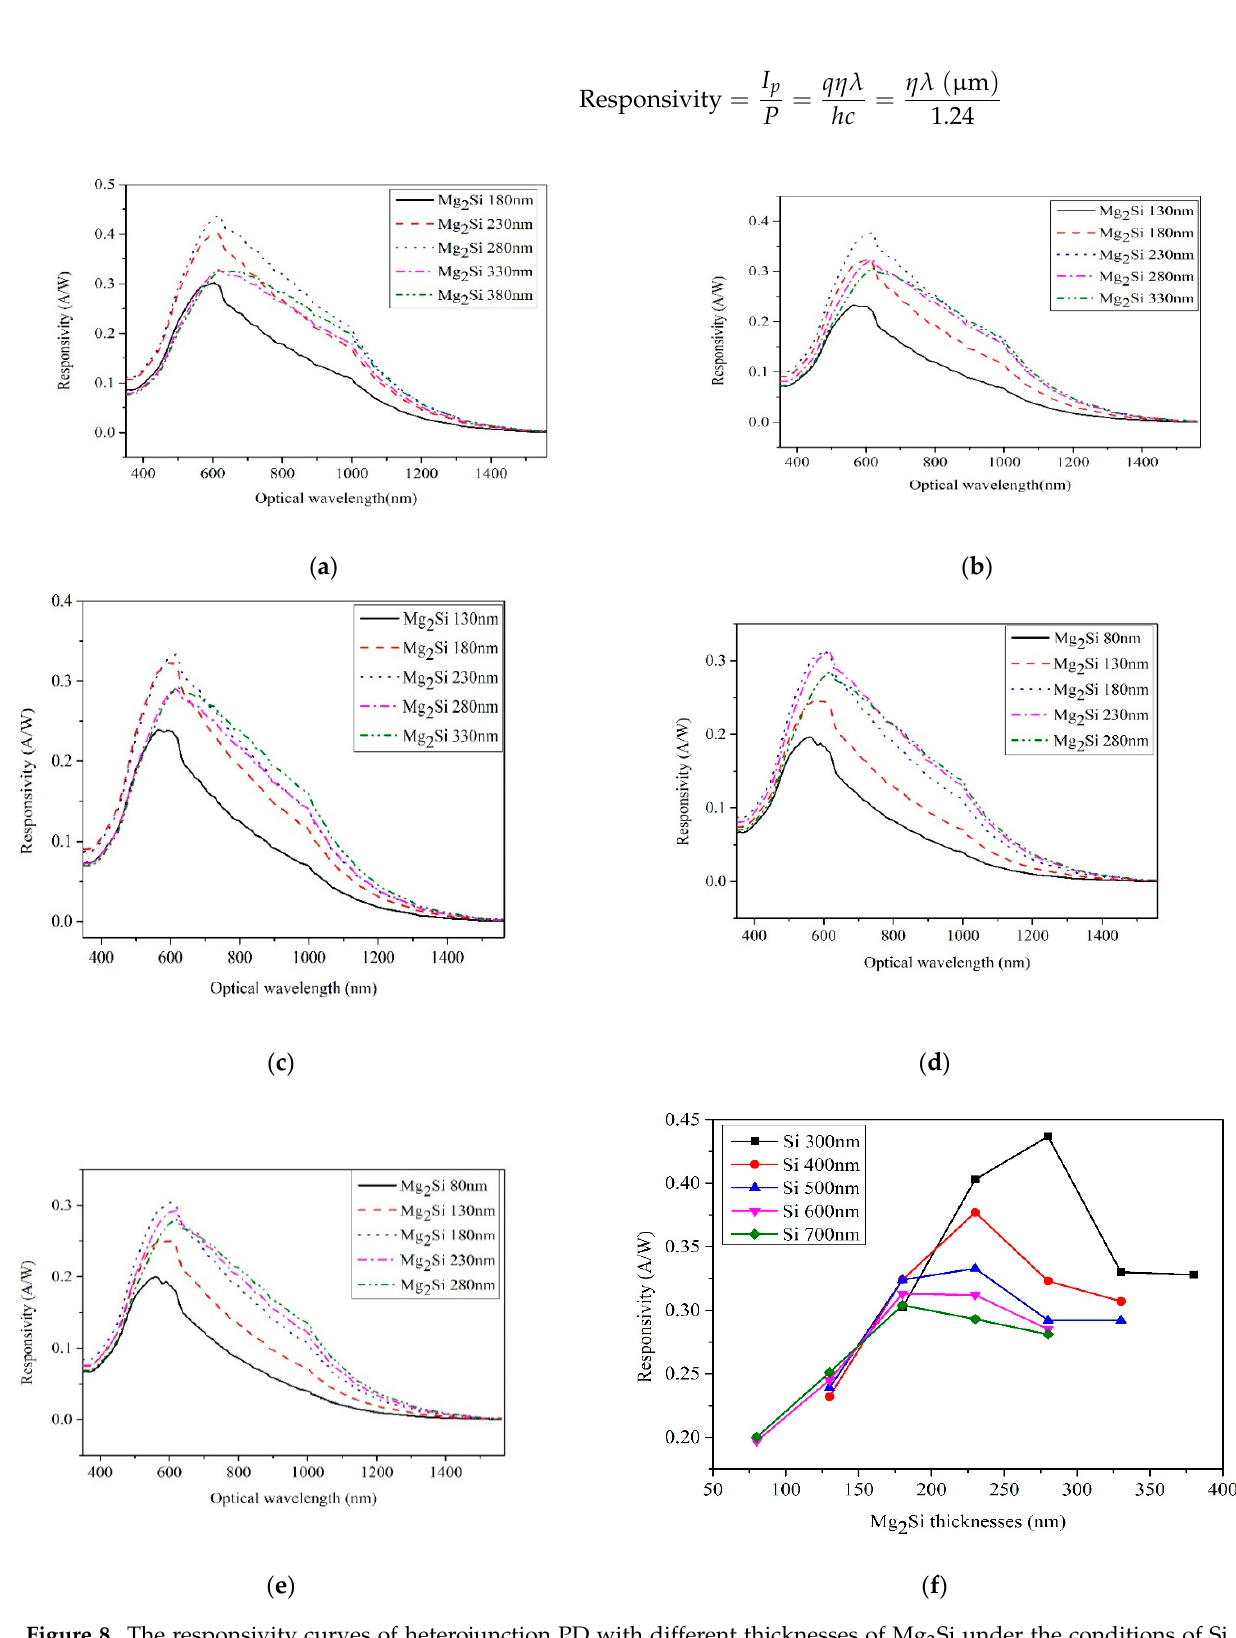
Figure 8. The responsivity curves of heterojunction PD with different thicknesses of Mg 2 Si under the conditions of Si thicknesses of 300 nm, 400 nm, 500 nm, 600 nm, and 700 nm. ( a ) Si-300 nm; ( b ) Si-400 nm; ( c ) Si-500 nm; ( d ) Si-600 nm; ( e ) Si-700 nm; ( f ) The effect of thicknesses on the responsivity.